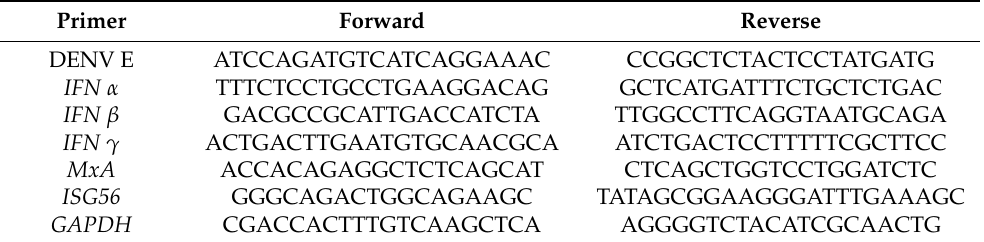
Table 1. Primer sequence (5 (cid:48) to 3 (cid:48)